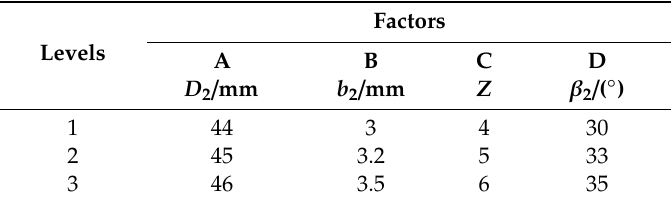
Table 3. Levels of factors in orthogonal experiments.